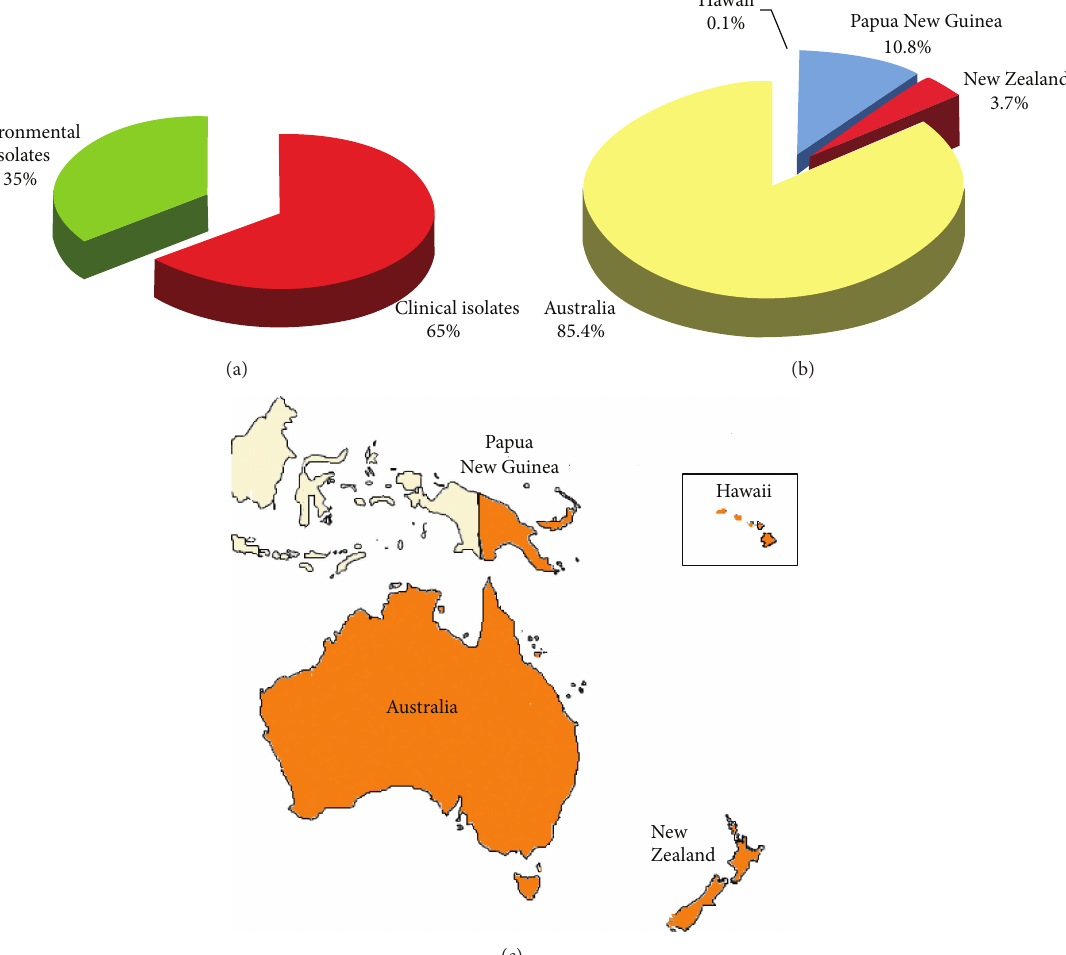
F 1: Percentage of Cryptococcus neoformans and Cryptococcus gattii isolates from clinical ( sources (a). Distribution of Cryptococcus neoformans and Cryptococcus gattii isolates in the different countries of Oceania (b). Map of the geographical distribution of the Cryptococcus neoformans and Cryptococcus gattii isolates in Oceania (c). Clinical isolates were reported from red-colored countries, whereas both clinical and environmental isolates were reported from orange-colored